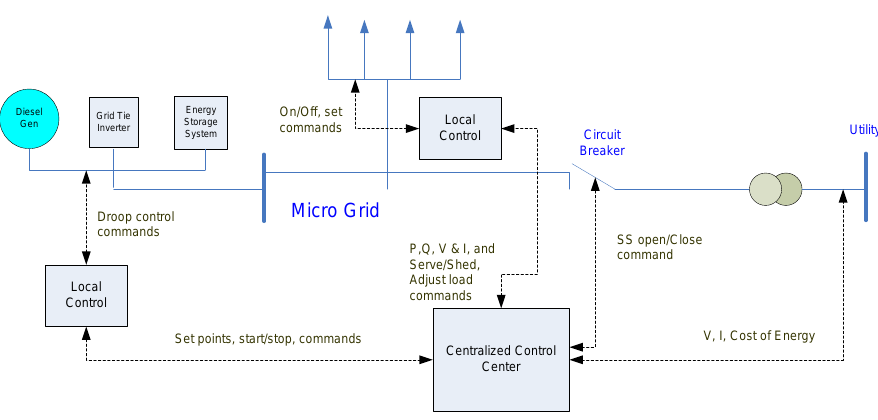
Figure 3. EMS controller data flow between controller, load and sources. Table 1. System specification considered for analysis.